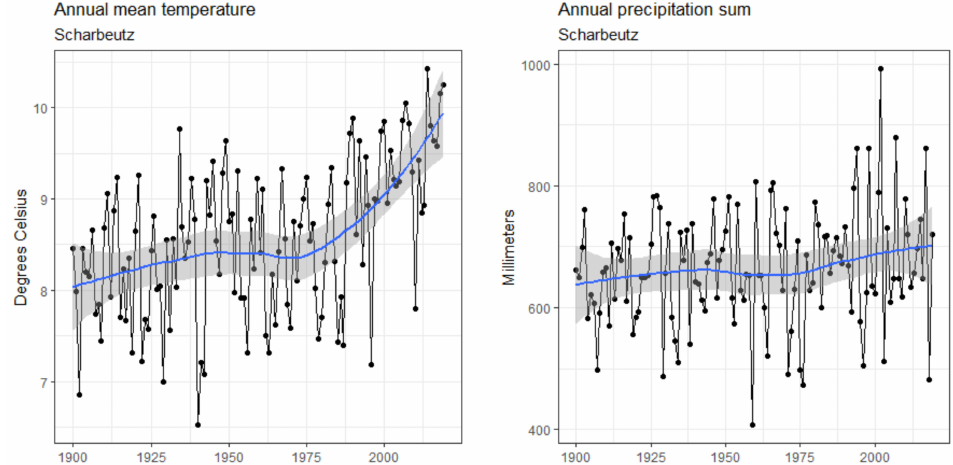
Figure 3. Plot of annual mean temperature ( left ) and annual precipitation ( right ) for Scharbeutz (northern Germany).